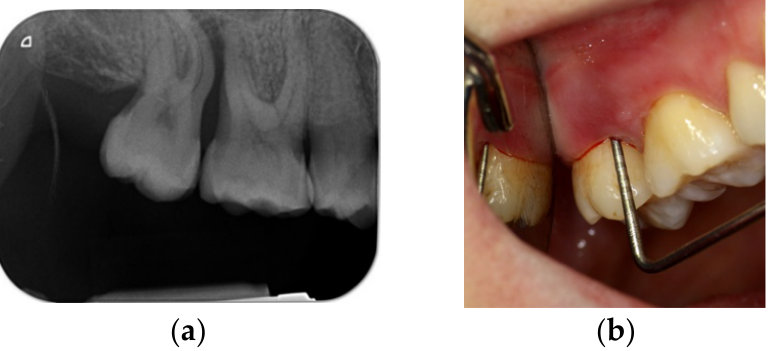
Figure 19. ( a ) Periapical radiograph of teeth 1.7, 1.6, 1.5; ( b ) important probing periodontal mesial root of 1.7. A large amount of infected granulation tissue was present in furcation space, between the distal-buccal and palatal root (Figure 20).